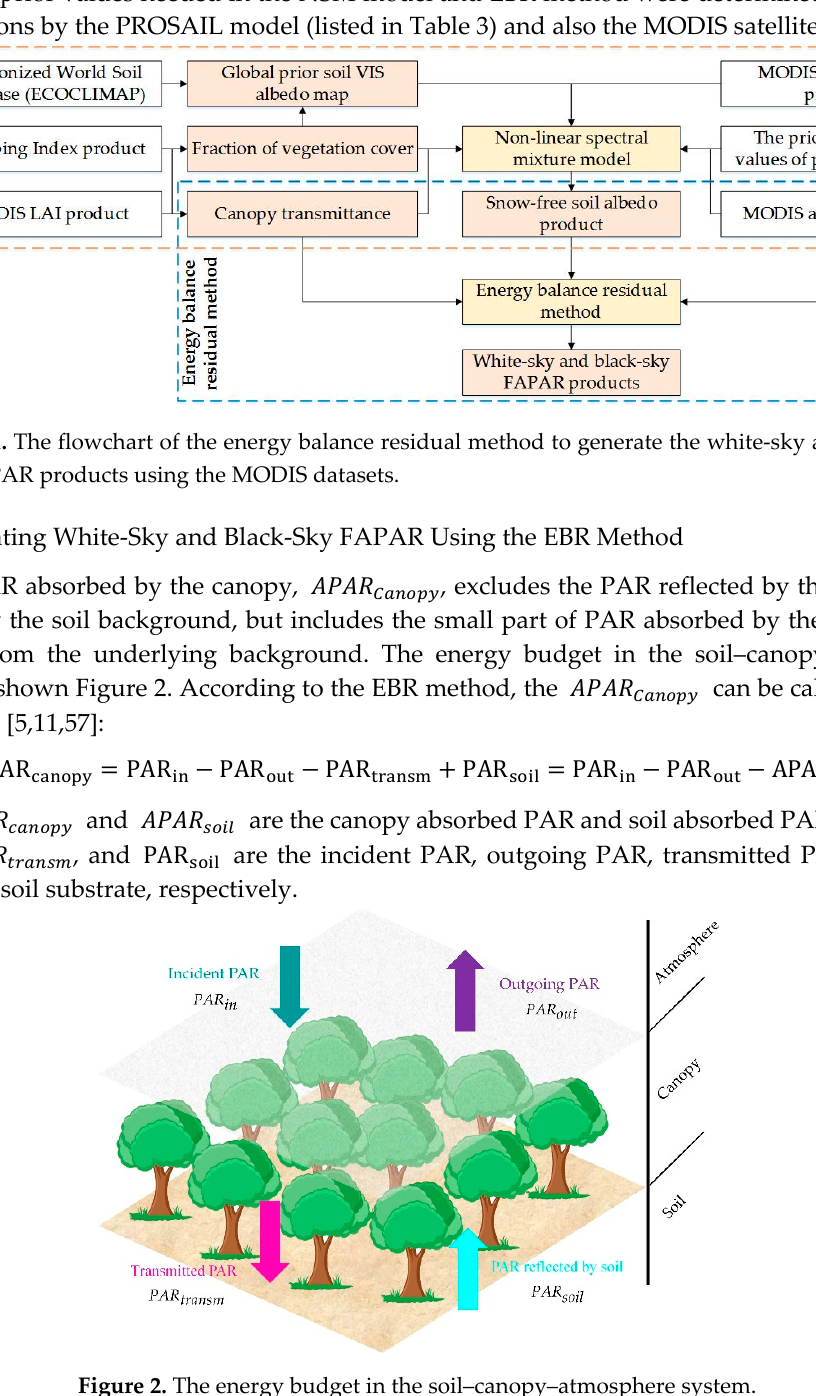
Figure 2. The energy budget in the soil–canopy–atmosphere